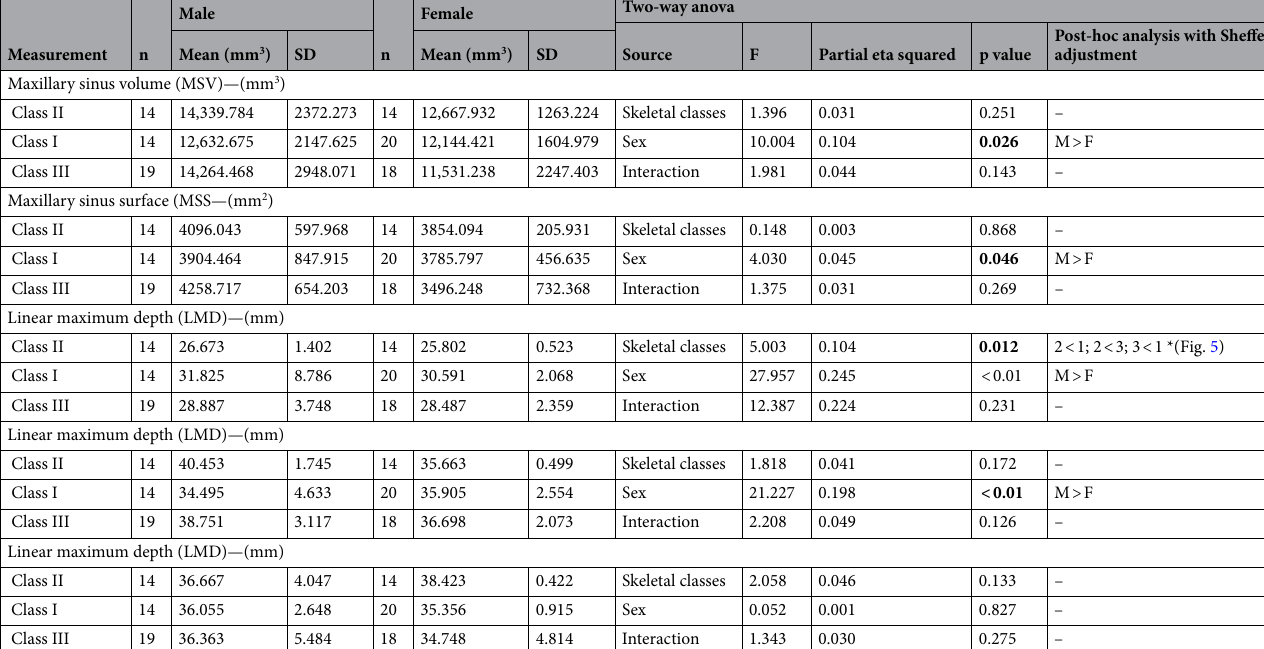
Table 3. Two-way ANOVA with ANB and gender as categorical independent variables and MS measurements. Significant values are in bold. A p value < 0.05 was considered statistically